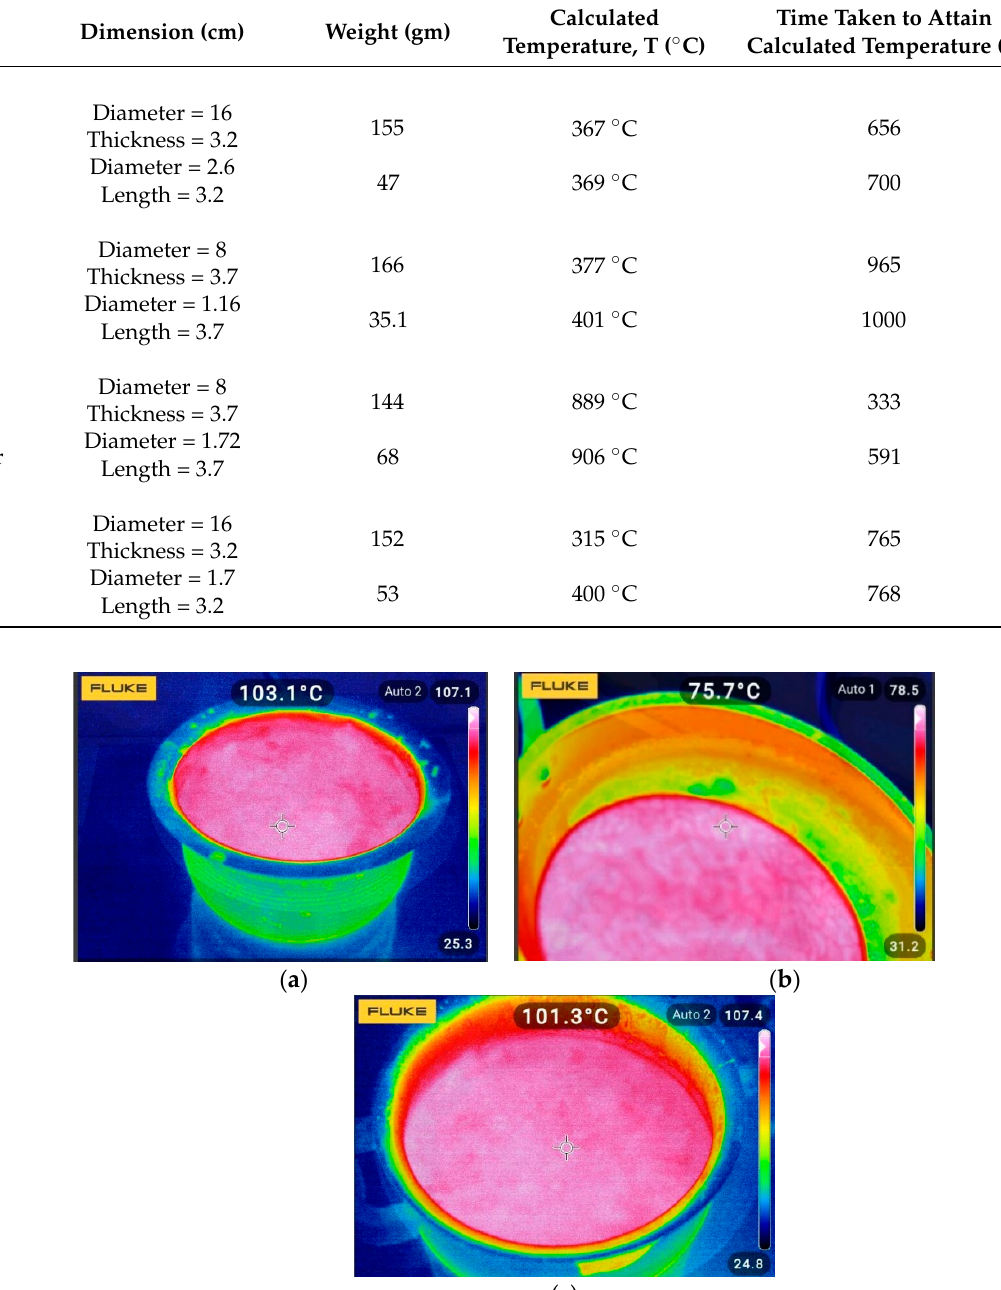
Table 2. Performance characteristics of metals in different heating modes.